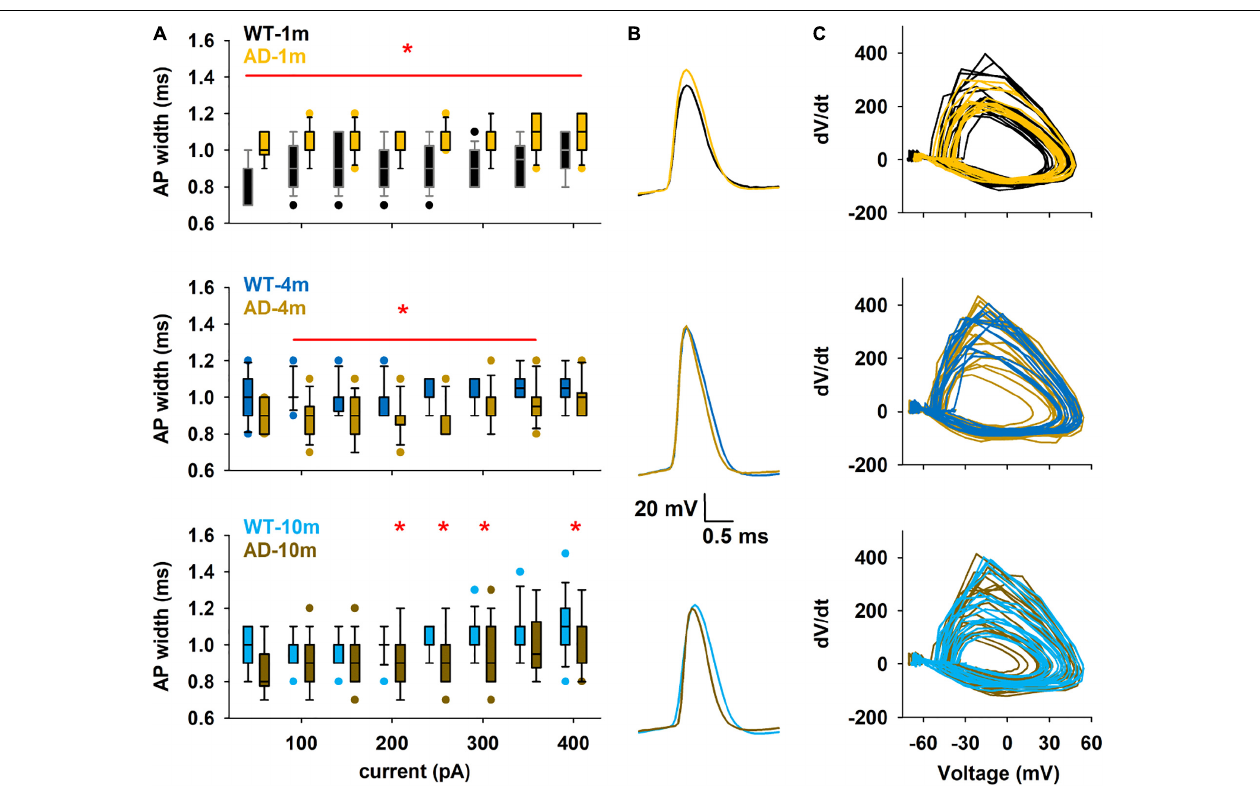
FIGURE 4 | Differences in the first Action Potential of train. (A) Box plot of first AP width in the different conditions as a function of current injection. The red line and symbol in each plot indicate the currents for which the average values were significantly different. * p ≤ 0.05. (B) Comparison of typical first APs under